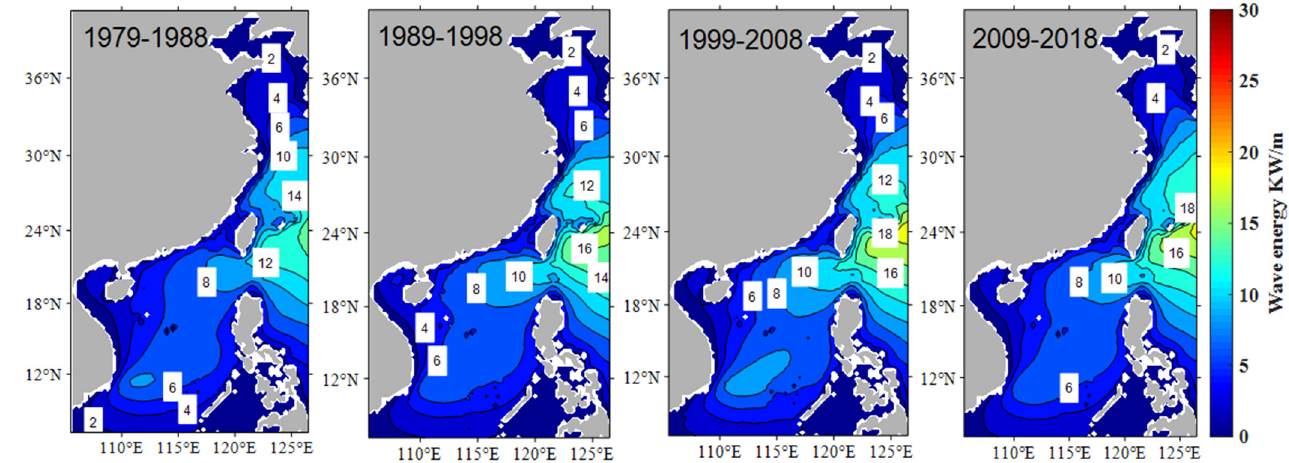
Figure 7. The decade distribution of P w in summer.